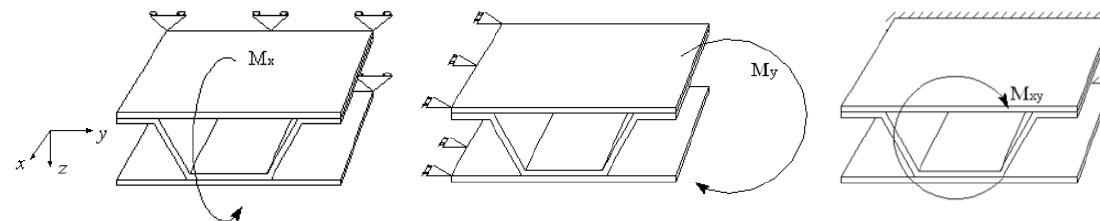
Figure 2: Load and constraint schemes to evaluate out of plane stiffness of the sandwich.